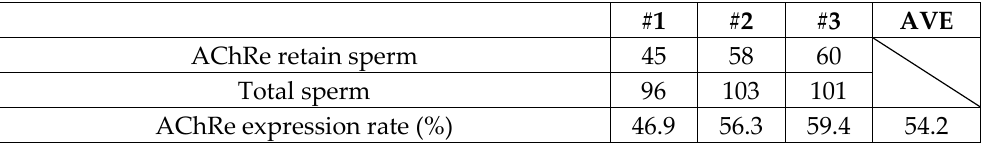
Figure 4. Mouse sperm AChRe localization analysis by immunocytochemistry. Note the immunoreactivity, which was detected at the anterior acrosomal region overlapping with PNA lectin signal. Blue, nuclear (Hoechst 33342); green, acrosome (FTIC-PNA); red, AChRe; bars = 10 µm. Table 1. AChRe expression rate in the mouse sperm. Each group was made up of a sperm mixture sample from three male mice. These three different sperm samples were prepared and tested in total and the average of the three trials was calculated.